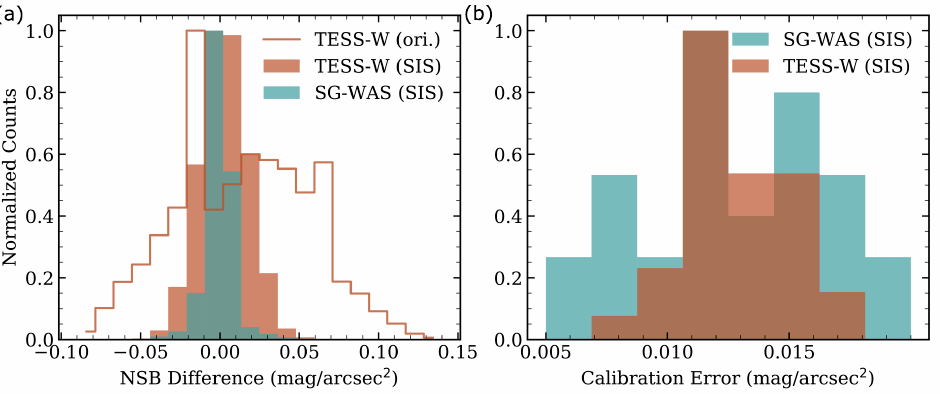
Figure 6. ( a ) Distribution of differences in simultaneous NSB measurements between pairs of TESS-W (brown) and SG-WAS (blue) photometers after calibrating them using the Sky Integrating Sphere (SIS) method. The distribution of TESS-W photometer pairs with the original calibration (ori.) given by the manufacturer is also shown unfilled. ( b ) Distribution of calibration errors for both photometers obtained with the SIS